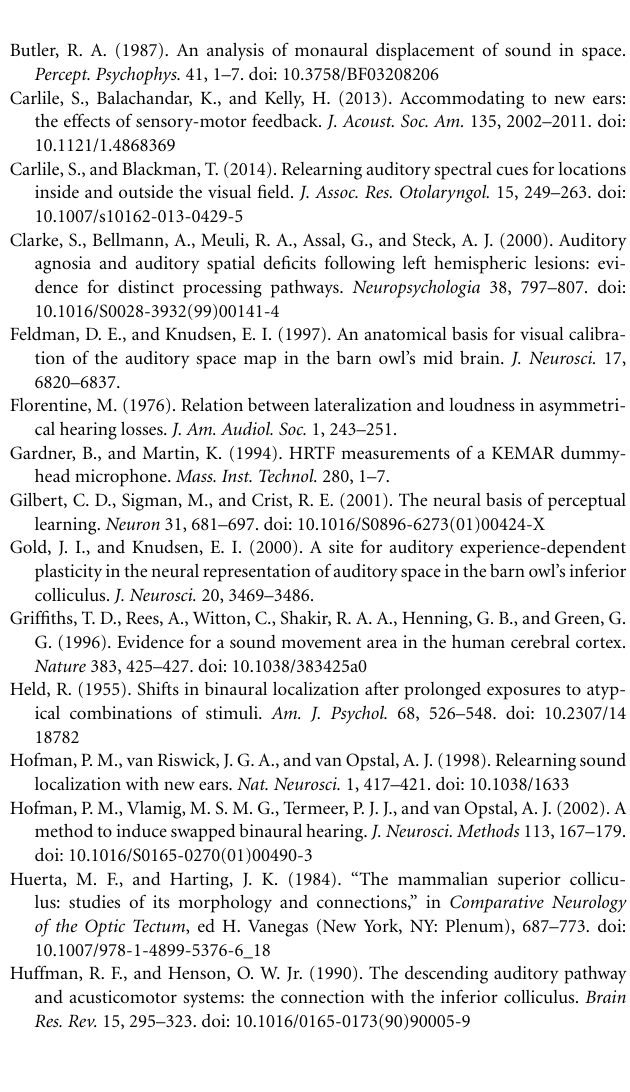
sources in space is most often accompanied by feedback. The feedback is compared to the auditory space percept (3). If no differences are found, then there is further tuning of the original cue combination rule. If the feedback is substantially different from the percept, then a new cue combination rule is